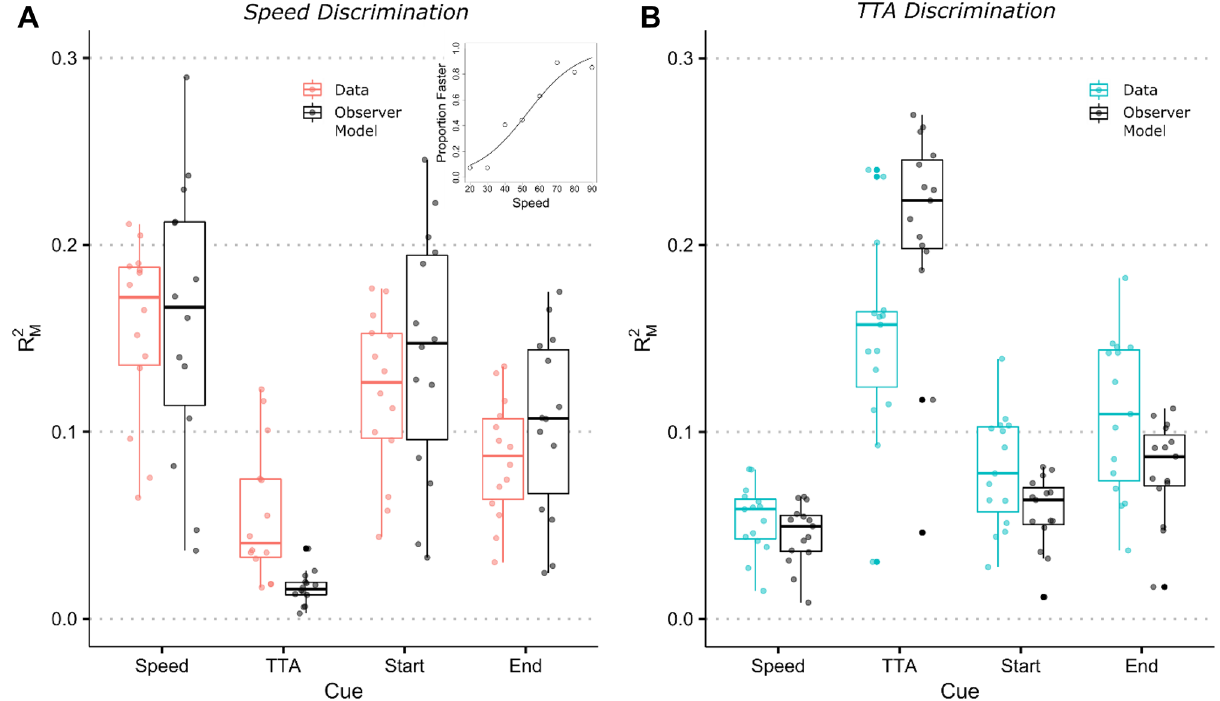
Figure 4. Average contribution of vehicle speed, time-to-arrival, start and end distance of the comparison vehicle to the model fits (R 2 M ) predicting the probability of “faster” or “earlier” responses. Average contributions are plotted as dots for each participant in ( A ) the speed discrimination task ( N = 14) and ( B ) the time-to-arrival discrimination task ( N = 15). Crossbars indicate the median. Whiskers depict the 1.5 × interquartile ranges. For comparison, average contributions are also plotted for a theoretical observer model responding only to the vehicle speed or time-to-arrival. The inserted panel depicts a general linear model fit for one exemplar participant predicting the proportion “faster” responses as a function of vehicle